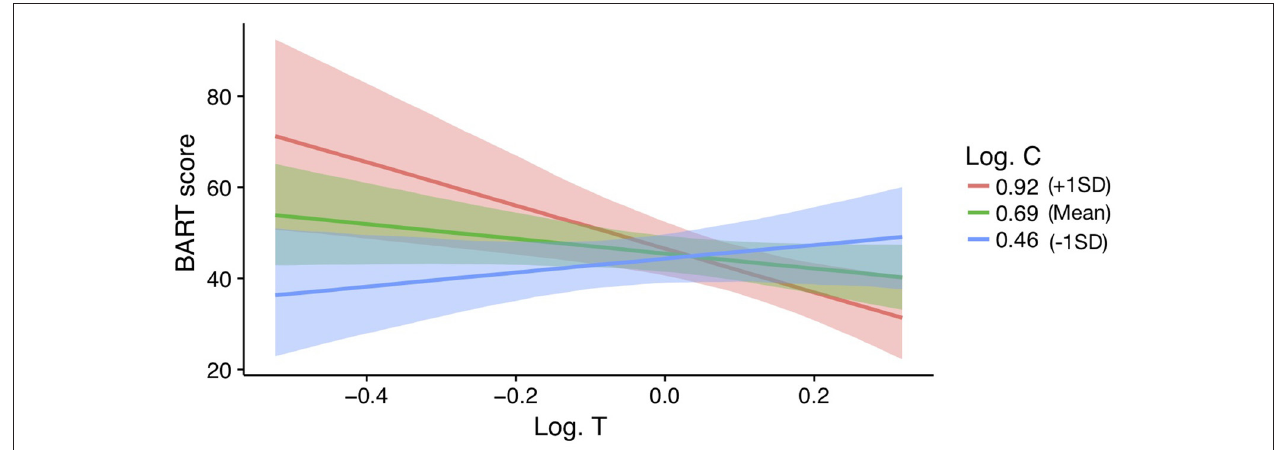
FIGURE 3 | Effect of log transformed testosterone (Log T) on BART scores for varying levels of Alog transformed cortisol (Log C) in men ( z -scored). Bands represent 95% confidence intervals.